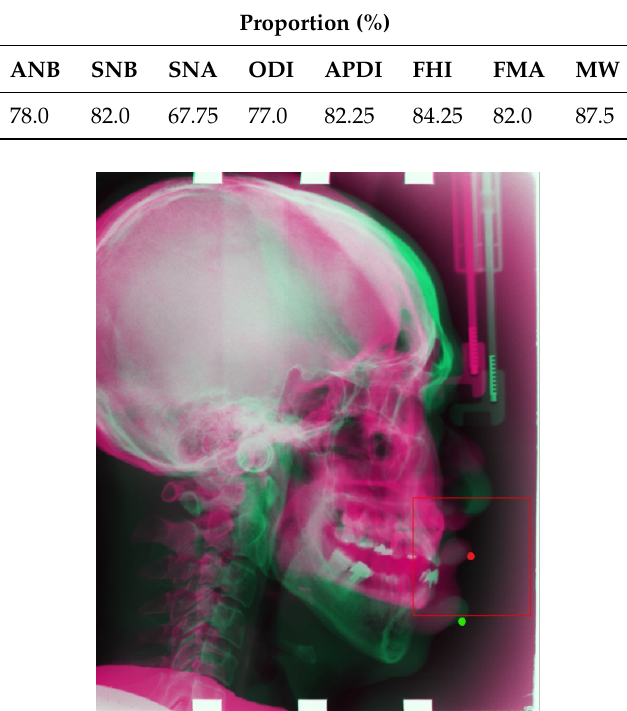
Figure 9. Green point: test image’s landmark location. Red point: reference image’s landmark location. We can see that the green dot is not included in the bounding box we cropped.